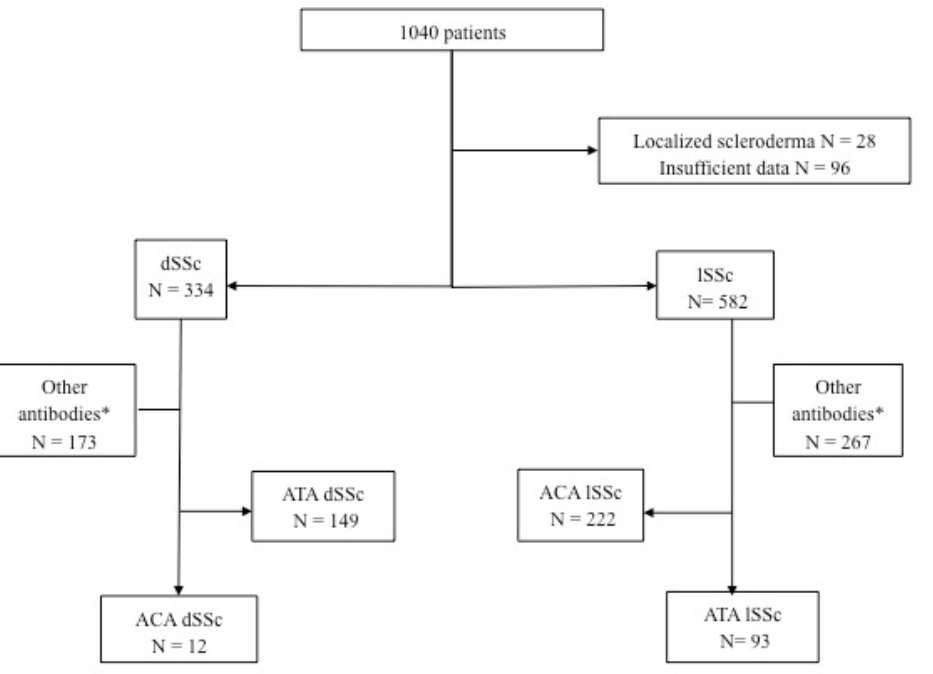
Figure 1. Flow chart of the study. * Other antibodies comprised patients without antibodies and with excluded antibodies (anti-RNA polymerase III, anti-U3 RNP, anti-PM Scl). ACA: anti-centromere antibodies; ATA: anti-topoisomerase 1 antibodies; dSSc: diffuse systemic sclerosis; lSSc: limited systemic